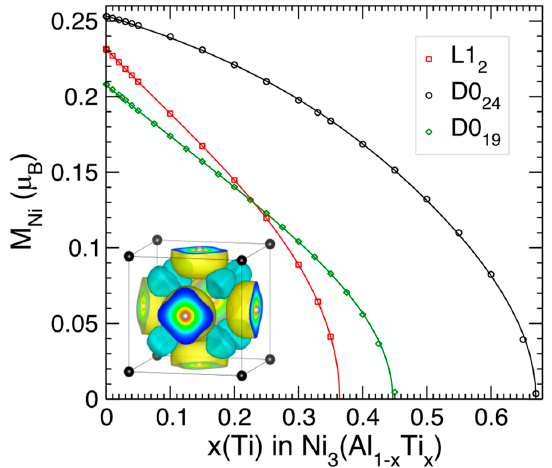
Figure 4. Ni atomic magnetic moment (Bohr magnetons, μ B /atom) versus Ti concentration x in three phases of Ni 3 (Al 1 − x Ti x ) alloys with a homogeneous atomic disorder on the Al/Ti sublattice. Lines are 6 th degree x ( M Ni ) polynomials with even powers, fitted to DFT data points. Inset: 0.0005 e - /Å 3 iso- surfaces of electronic spin density in cubic L1 2 Ni 3 Al unit cell with Ni (grey) and Al (black) atoms.